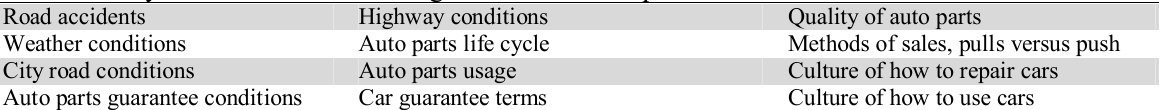
The summary of 12 factors influencing demand for auto parts